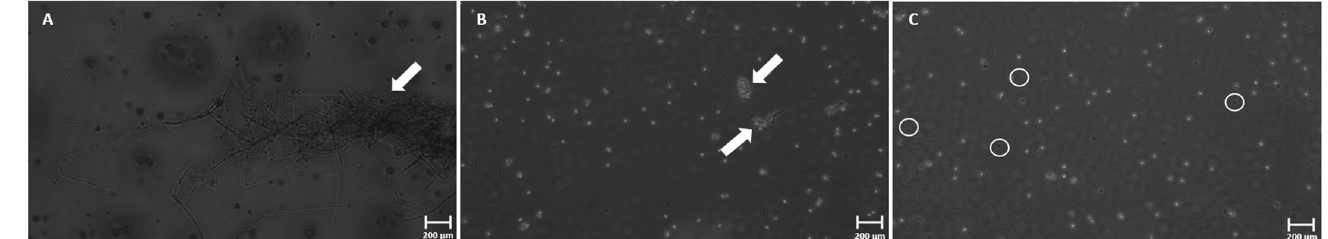
Figure 7. Phase-contrast microscopy images (20X magnification) of the commercial apple juice inoc- ulated with B. nivea ascospores in spores activated by HPP at 600 MPa for 3 min at 17 ◦ C, stored for 30 days at atmospheric pressure (AP) at room temperature (RT) ( A ), under refrigeration at 4 ◦ C ( B ) and under hyperbaric storage at 150 MPa at RT ( C ). The white arrow highlights hyphae formation, while the white circles highlight dead ascospores (displayed as dark phase